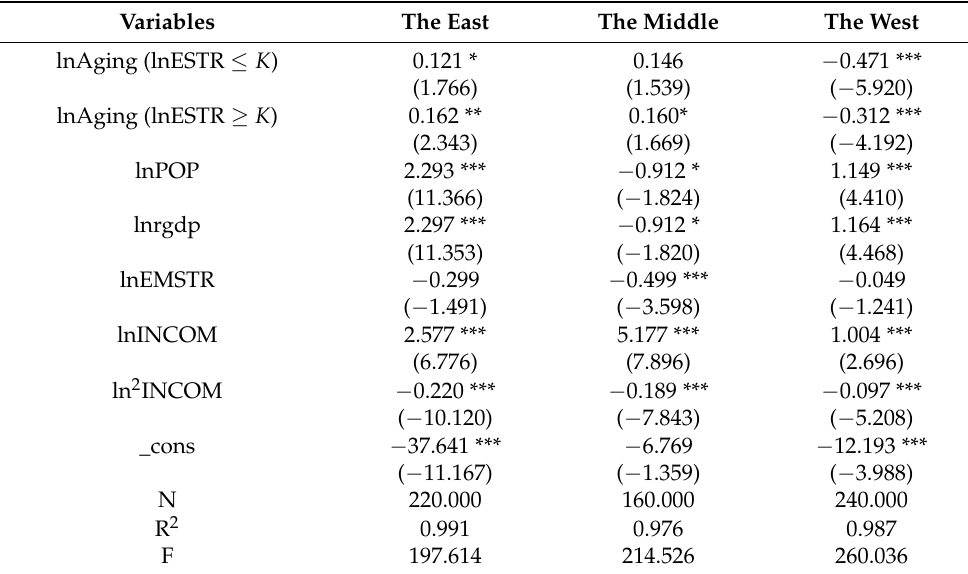
Table 11. The threshold effect of energy consumption structure on the impact of aging on carbon emissions in eastern, central and western